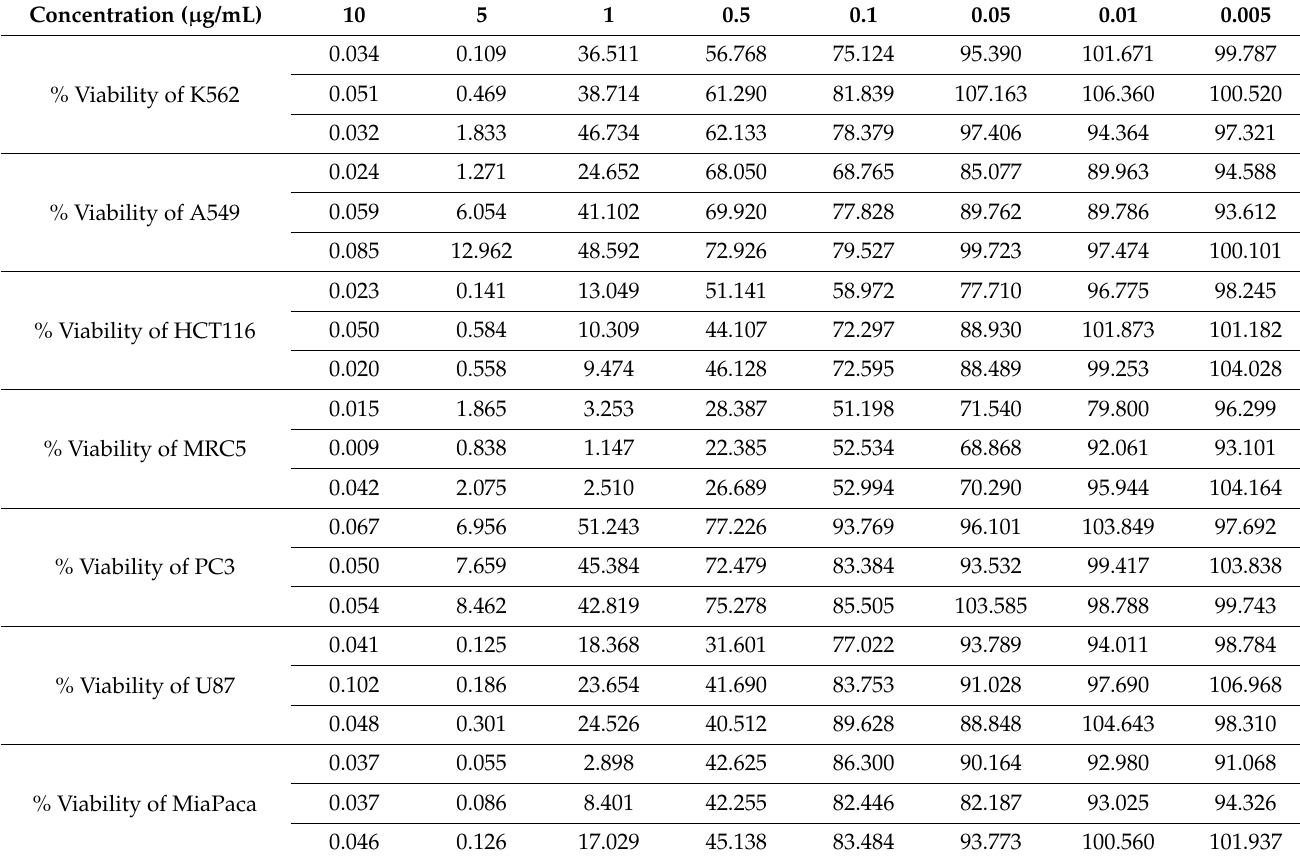
Table 6. Results of cytotoxicity activity of essential oils of Lavandula coronopifolia